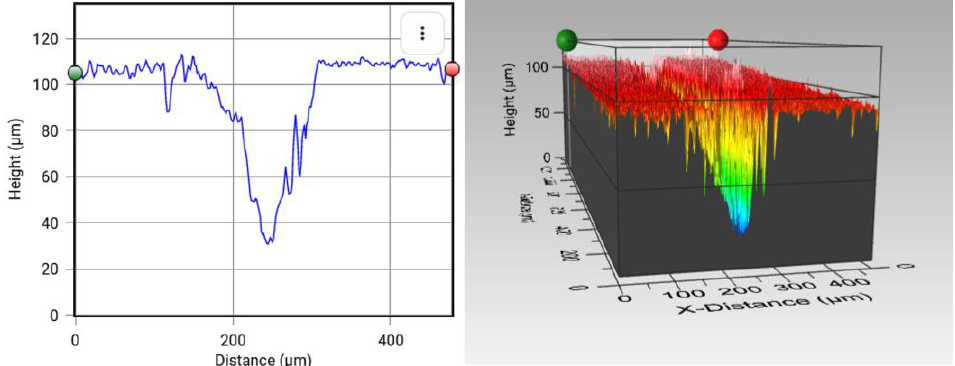
Figure 8. Initial damage created by the scalpel.